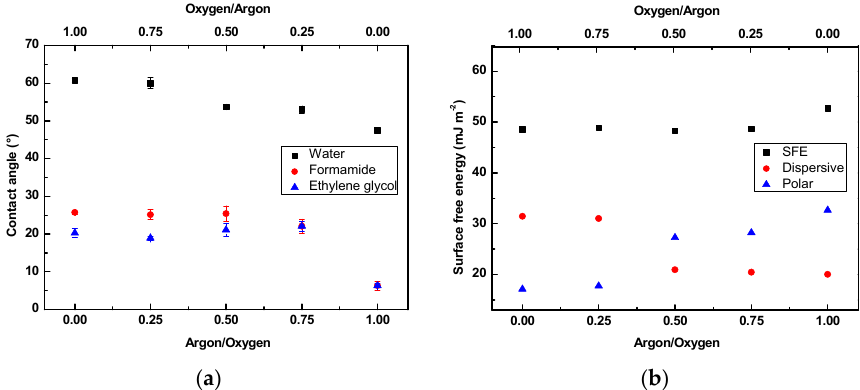
Figure 4. Surface wettability of LDPE treated using argon/oxygen plasma for 120 s as a function of gas concentration ratio: ( a ) contact angle of water; ( b ) surface free energy (SFE).